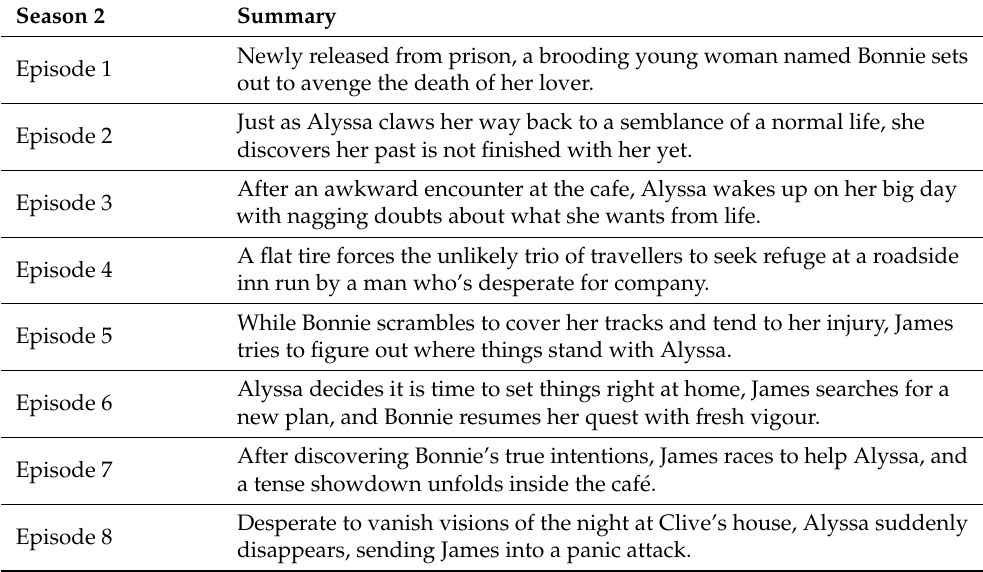
Table A2. Episode guide. Source: IMDb